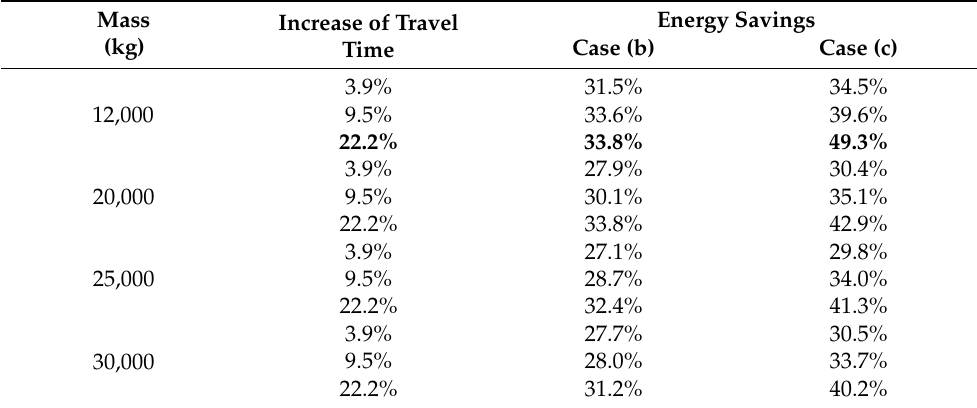
Table 6. Relative energy savings of case (b) and (c) with respect to the increase of travel time compared to the single truck case with constant speed in case